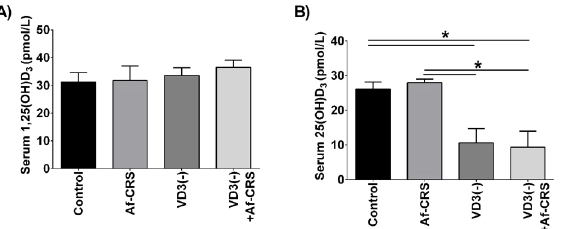
Fig 4. Af-CRS does not alter serum levels of 1,25(OH) 2 D 3 or 25(OH)D 3 . (A) Serum 1,25(OH) 2 D 3 levels were not significantly different amongst groups, regardlessof diseaseor dietary VD3 status. ( B) Serum 25 (OH)D 3 levels are not impactedby local inflammation associatedwith Af-CRS. As expected,mice with dietary VD3 deficiencydemonstrate reducedcirculating25(OH)D 3 levels. N = 4 mice/group. * p < 0.05between